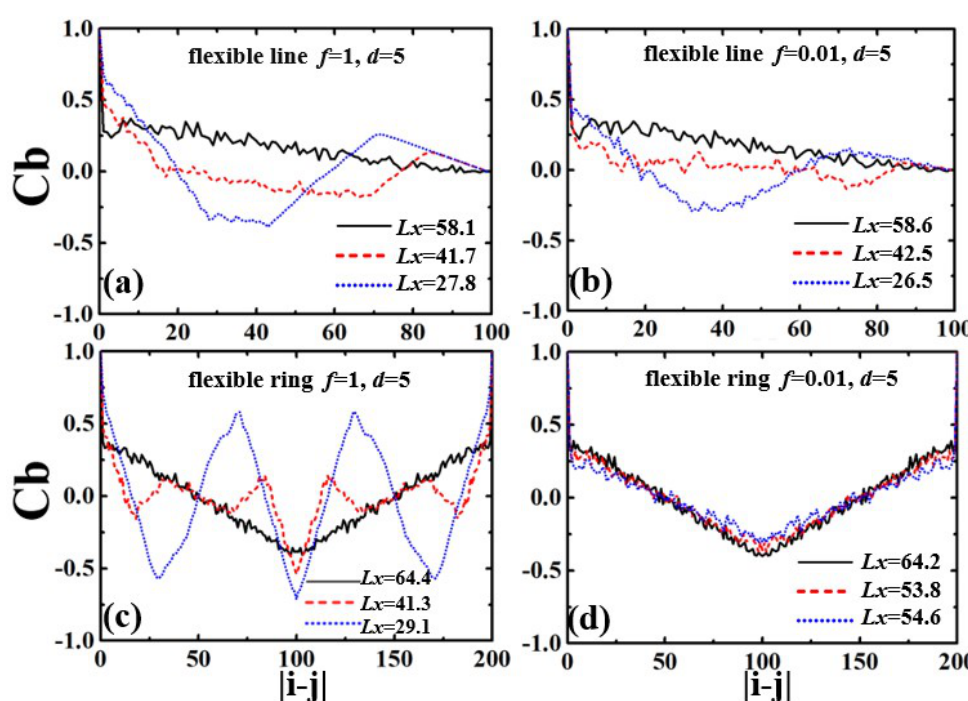
Figure 6. Bond correlation functions C b of the confined flexible chains in the compression processes: ( a ) linear polymer within f / k B T = 1.0 and d = 5, ( b ) linear polymer within f / k B T = 0.01 and d = 5, ( c ) ring polymer within f / k B T = 1.0 and d = 5, ( d ) ring polymer within f / k B T = 0.01 and d = 5.